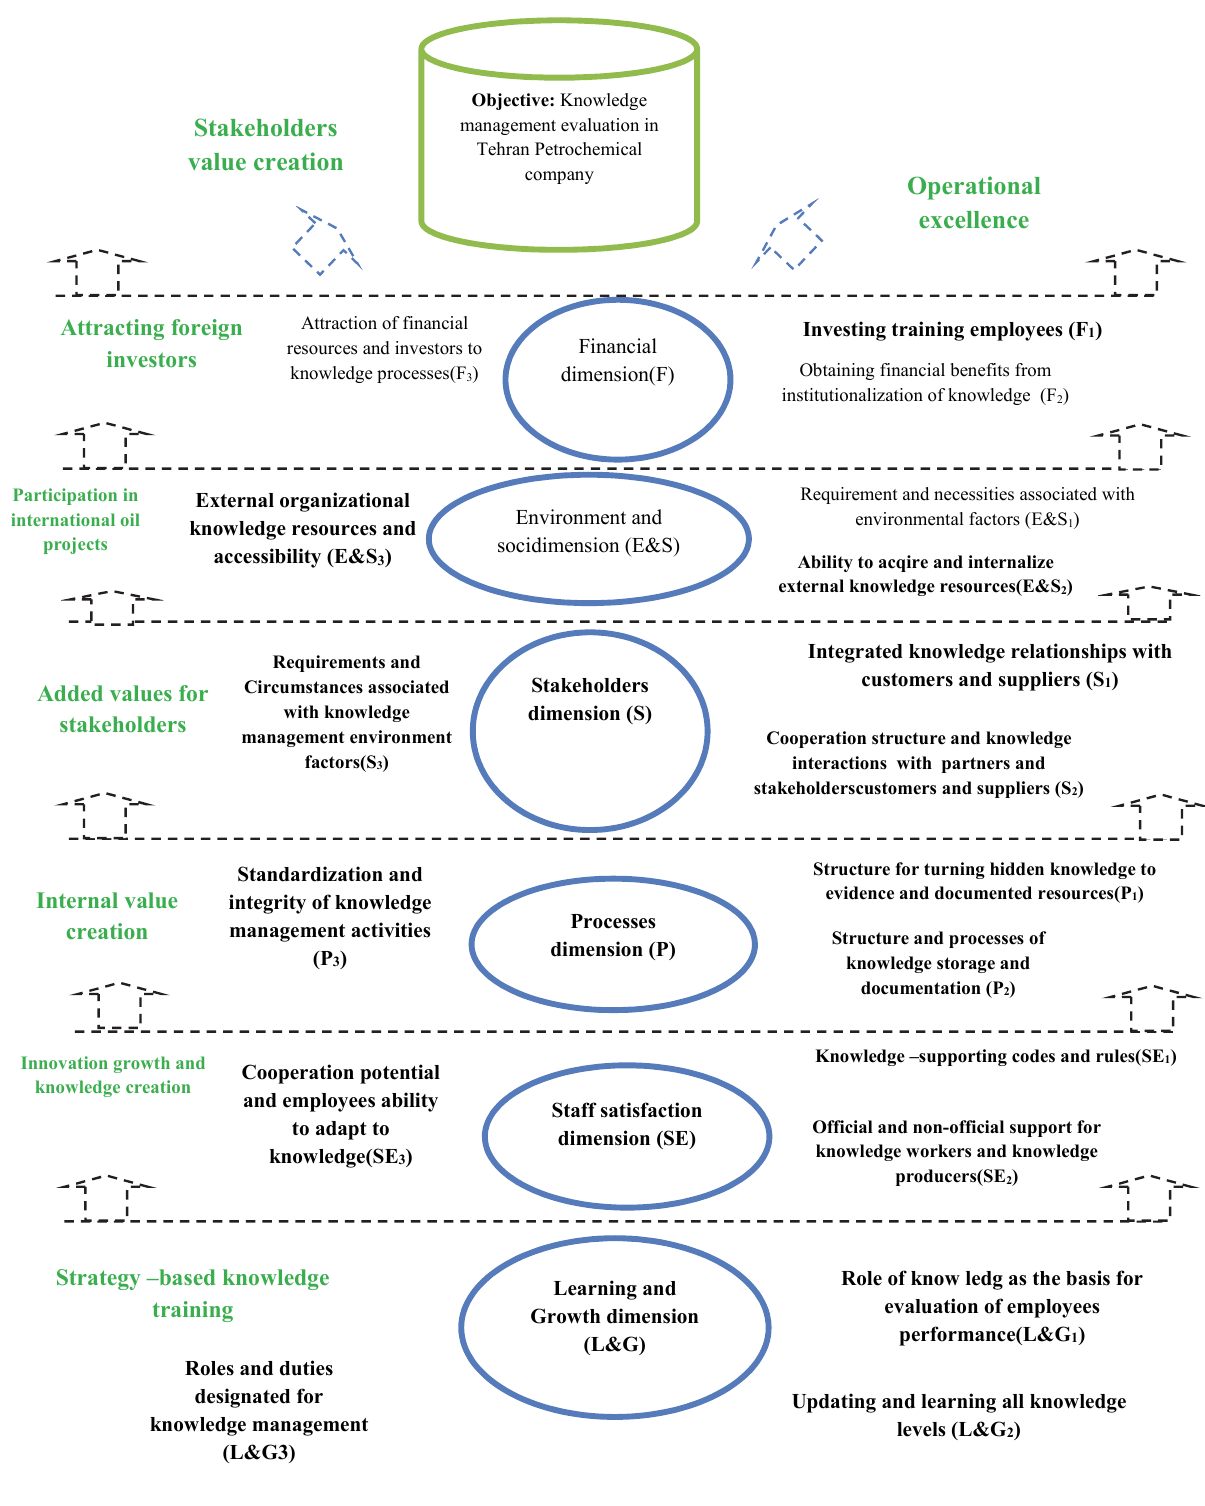
Fig. 3. Present Conceptual model and strategic map of petrochemical industries with